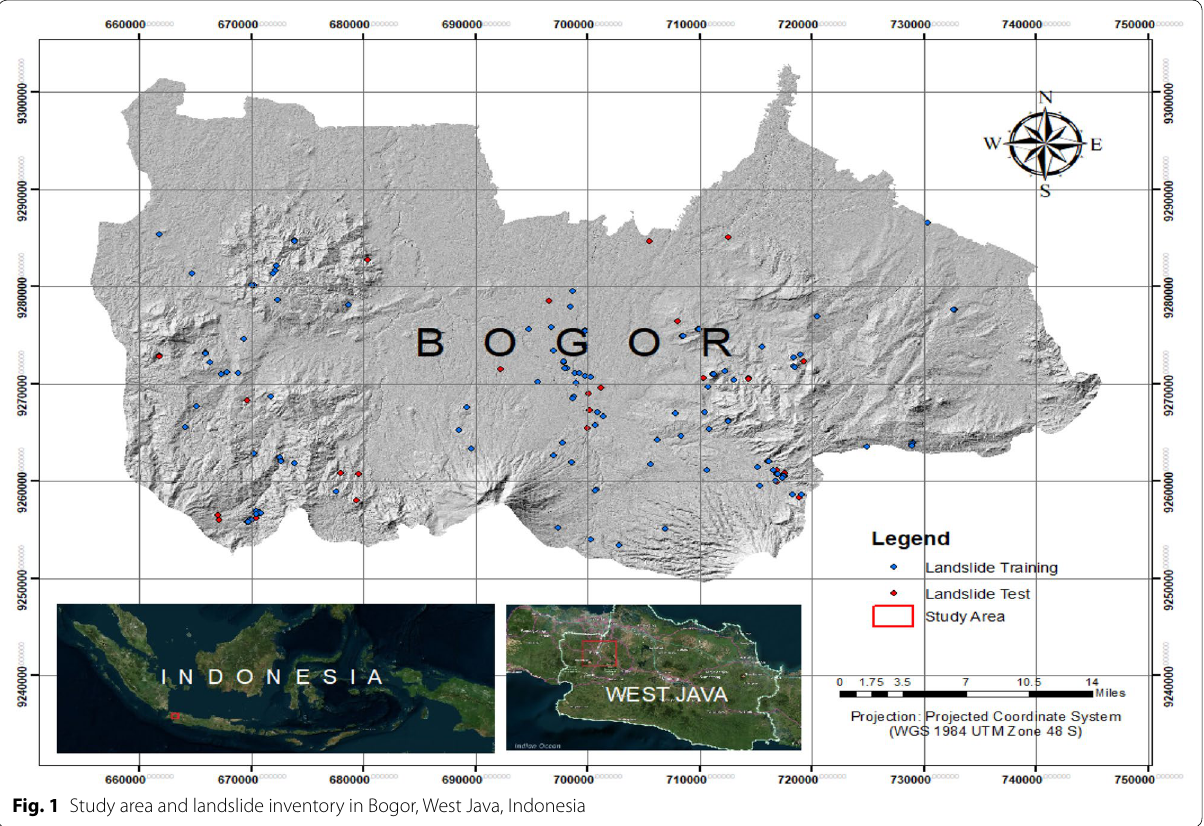
Fig. 1 Study area and landslide inventory in Bogor, West Java, Indonesia